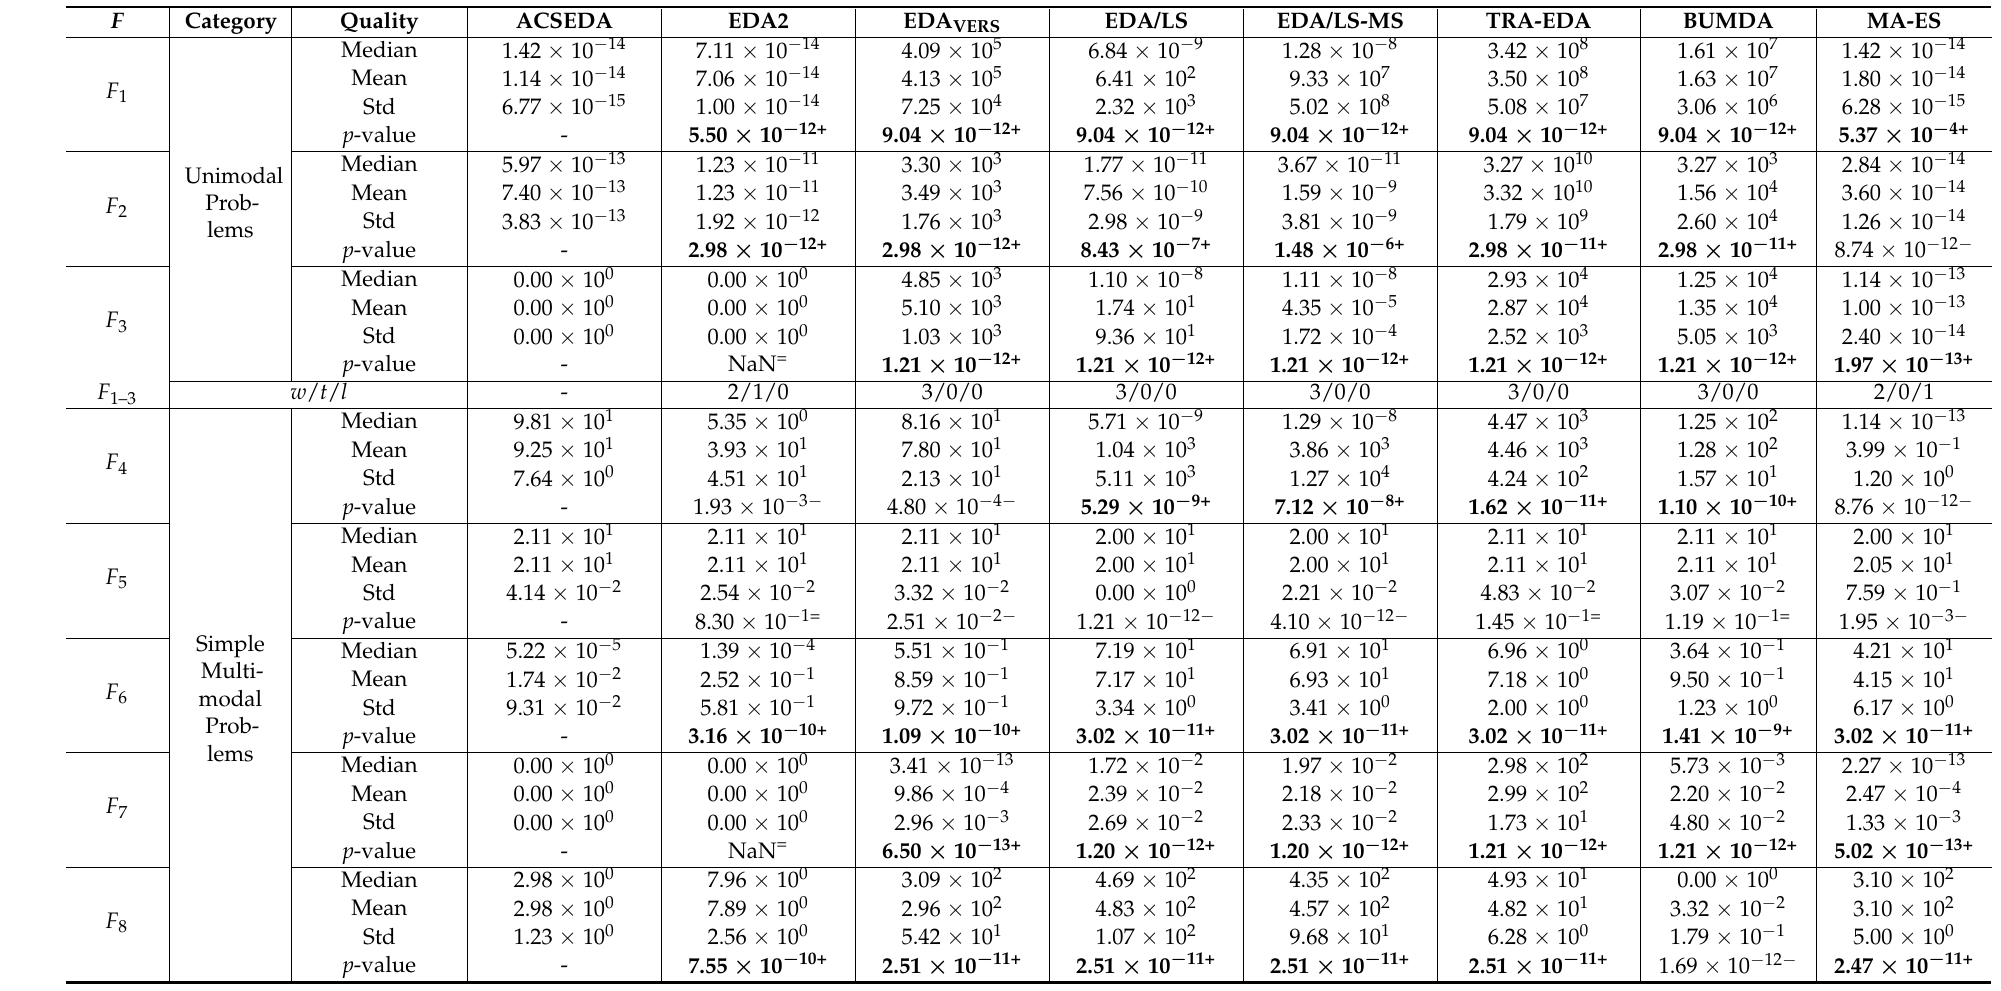
Table 3. Comparison between ACSEDA and the compared state-of-the-art EDA variants on the 50- D CEC2014 benchmark problems. The bold results indicate that ACSEDA is significantly better than the compared